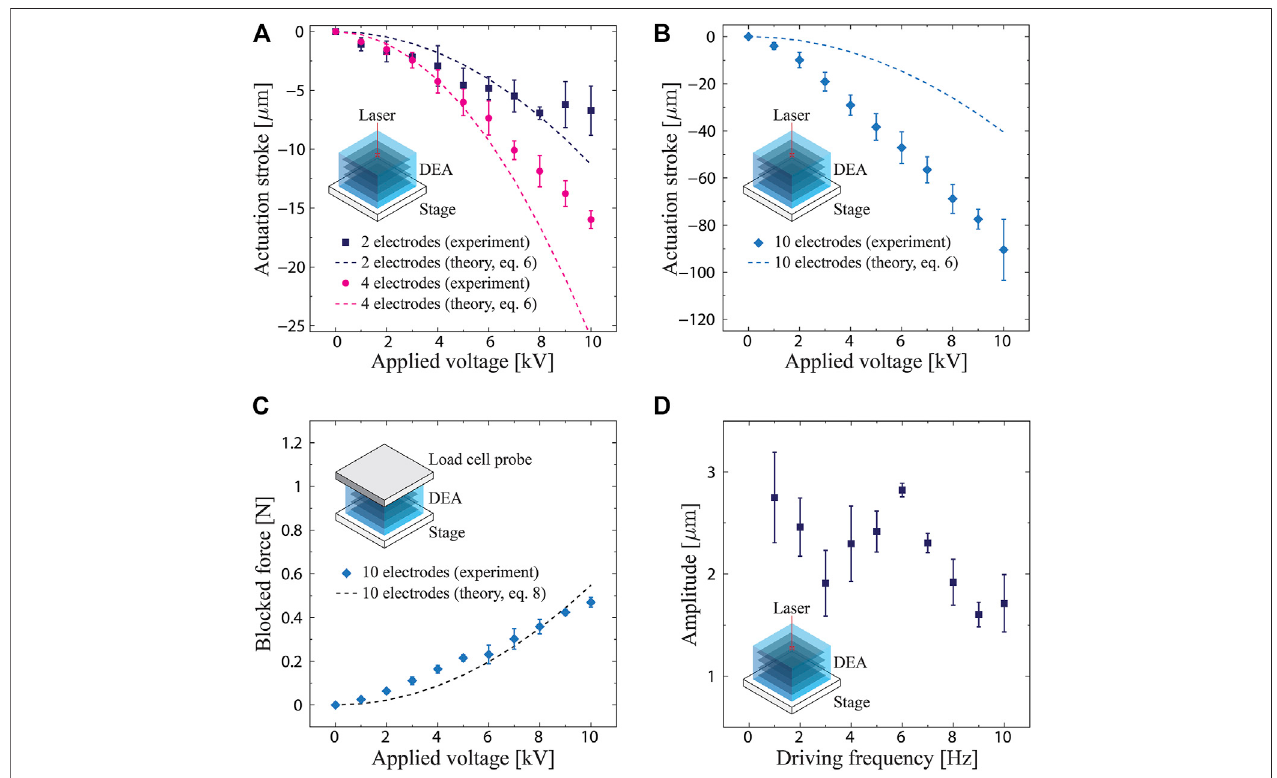
FIGURE 3 | Measured performance of the fabricated actuators. (A) Actuation stroke as a function of the applied voltage for the actuators with two and four electrodes. (B) Actuation stroke as a function of the applied voltage for the actuator with 10 electrodes. (C) Output force as a function of the applied voltage for the actuator with 10 electrodes. (D) Amplitude as a function of the driving frequency (voltage 3 kV).